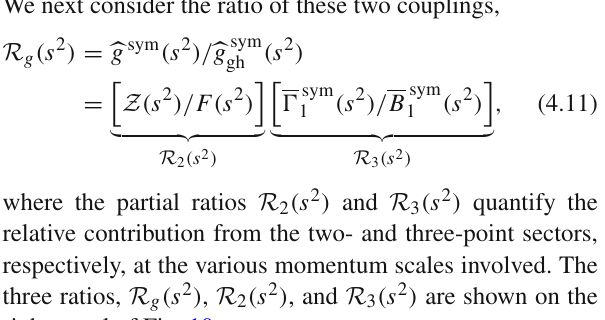
Fig. 9 Left panel: (cid:2) sym 1 ( s ) (black continuous line) compared with the form factor B sym 1 ( s ) of the ghost-gluon vertex (red dashed curve), in the symmetric configuration. Right panel: The gluon and ghost dressing functions, Z ( s ) and F ( s ) ,